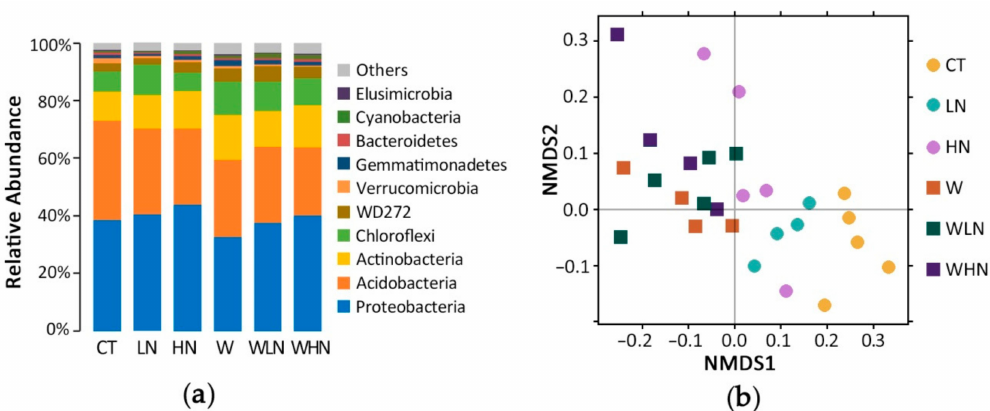
Figure 1. Composition of the bacterial community in the subtropical soil, based on the 16S rRNA gene. ( a ) Relative abundance of the top 10 phyla within the microbial community. ( b ) β -diversity